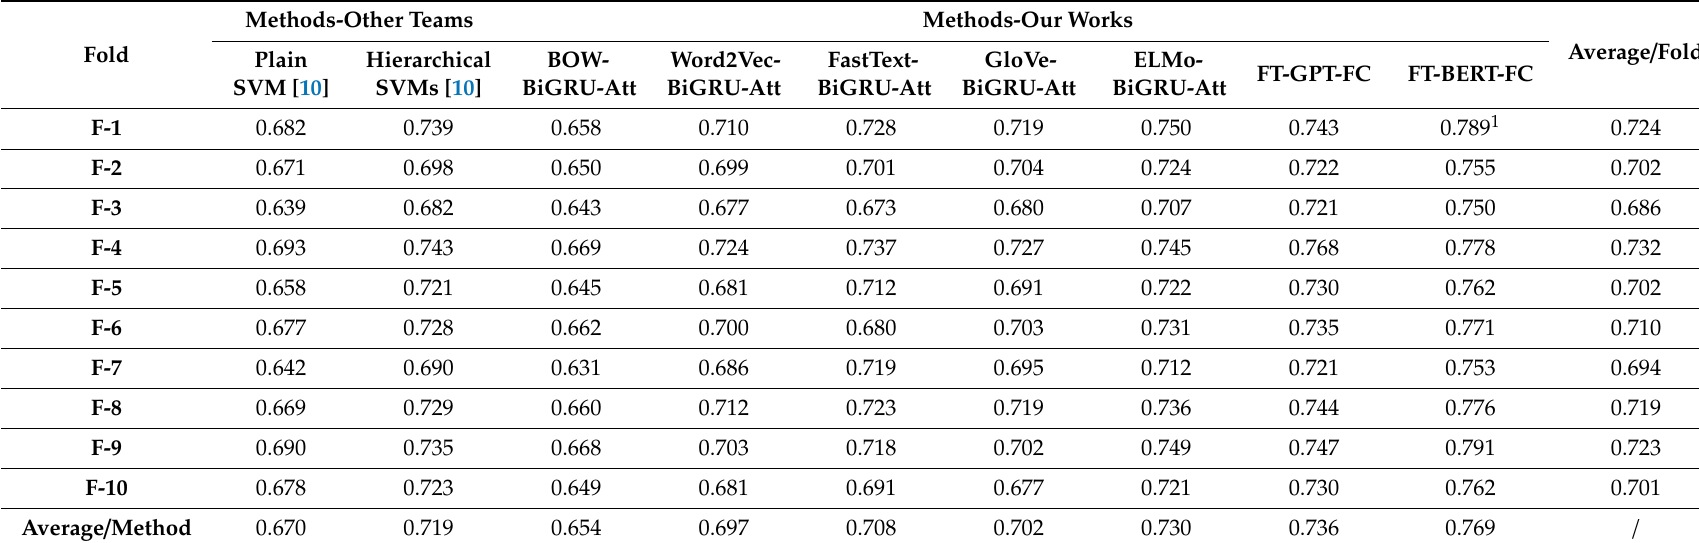
Table 4. The 10-fold cross-validation Micro- F 1 score on all